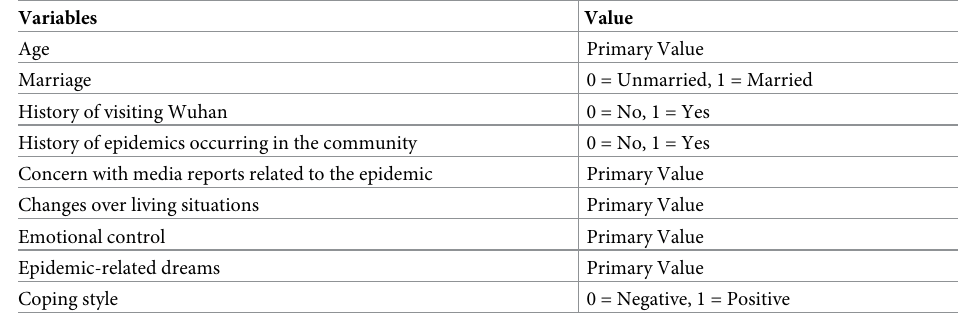
Table 3. Factors’ values assigned in the stepwise multiple linear regression model.